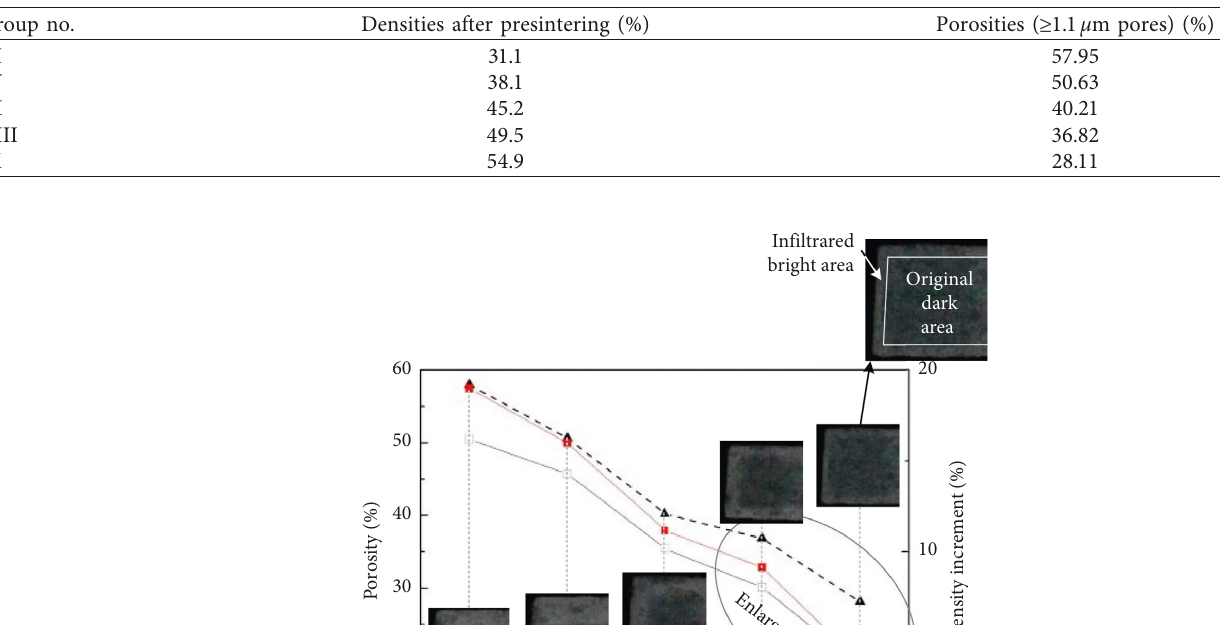
Table 5: Porosities of large-scale pores (